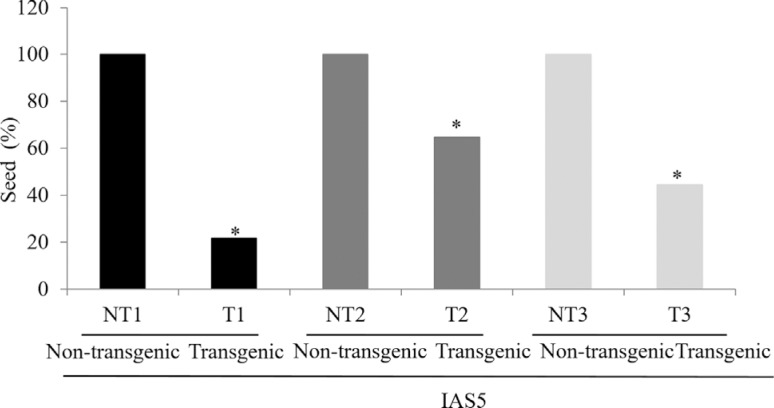
Relative percentage of seeds produced by transgenic plants in three generations (T1, T2 and T3). The mean number of seeds produced by non-transgenic plant was considered 100%. Transgenic plants and non-transgenic plants are from cv. IAS5. * indicates that the mean of transgenic seeds is significantly different from non-transgenic in each generation (t-test, p < 0.05).